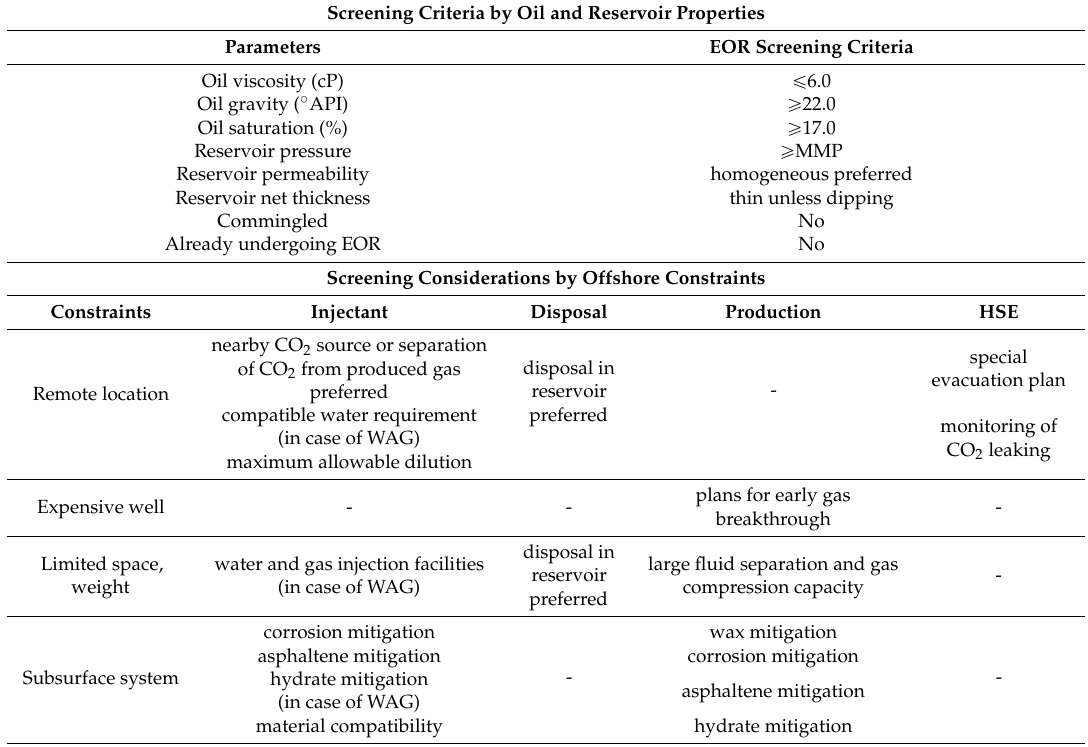
Table 5. New screening criteria for the CO 2 miscible